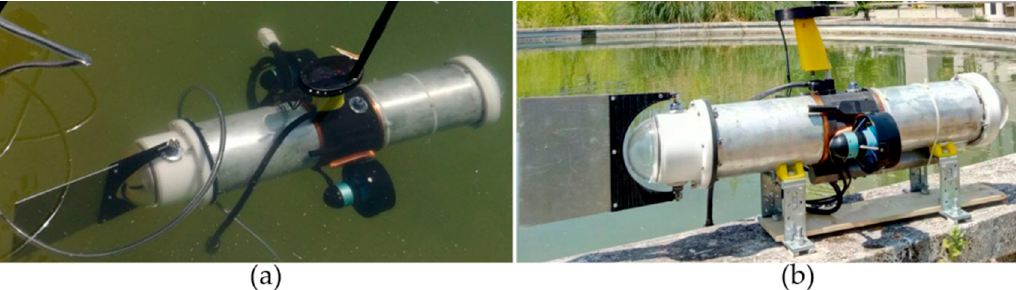
Figure 2. The ostraciiform swimming robot called “DORI”: ( a ) upper and ( b ) side views [1,6].